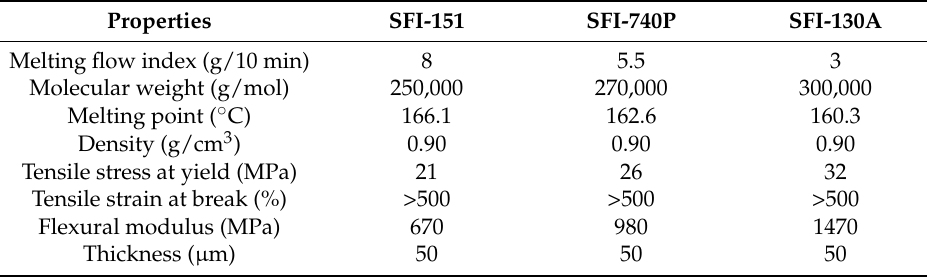
Table 1. Characterizations of films from the manufacturer’s